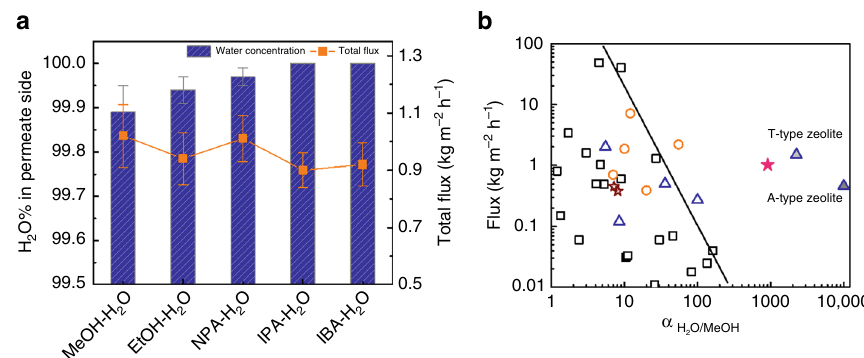
Fig. 6 Alcohol dehydration performance and comparison with literature. a 50 : 50 wt.% alcohol/water binary mixture separations by pervaporation with ED-GO@PSSHF membrane at 70 °C (error bars derived from SD); b comparison of ED-GO@PSSHF membrane with polymeric and inorganic membranes for the separation of methanol-water mixtures (squares, cycles, and triangles represent polymeric, silica, and zeolite membranes, respectively, open and solid stars indicate the reported GO based membranes and ED-GO@PSSHF membrane, respectively)